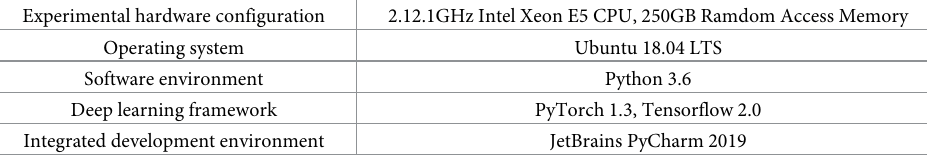
Table 2. Experimental environment and